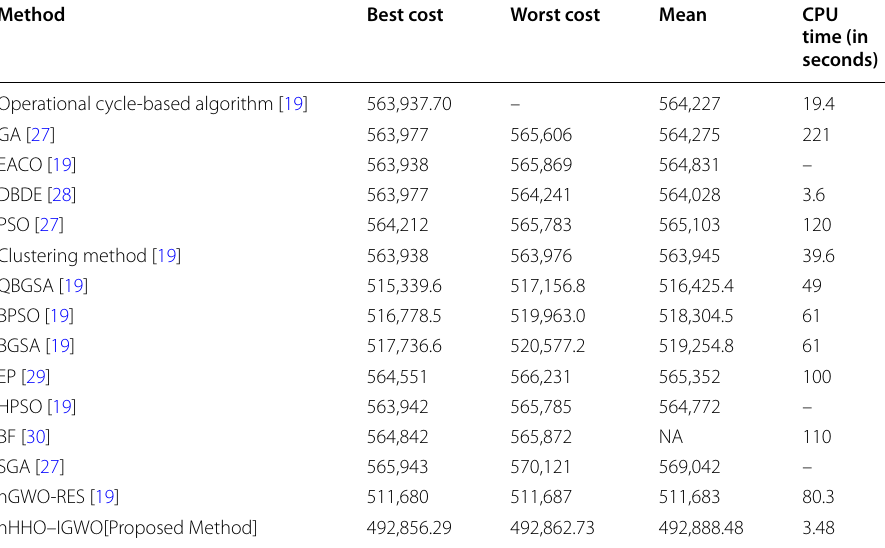
Table 8 Comparison of 10-unit wind–thermal system with other